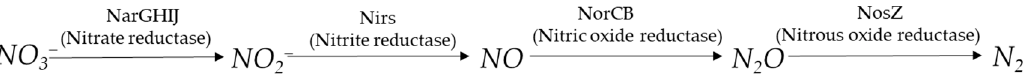
Figure 3. Denitrification enzymes that reduce NO 3 − to N 2 (nitrogen gas).